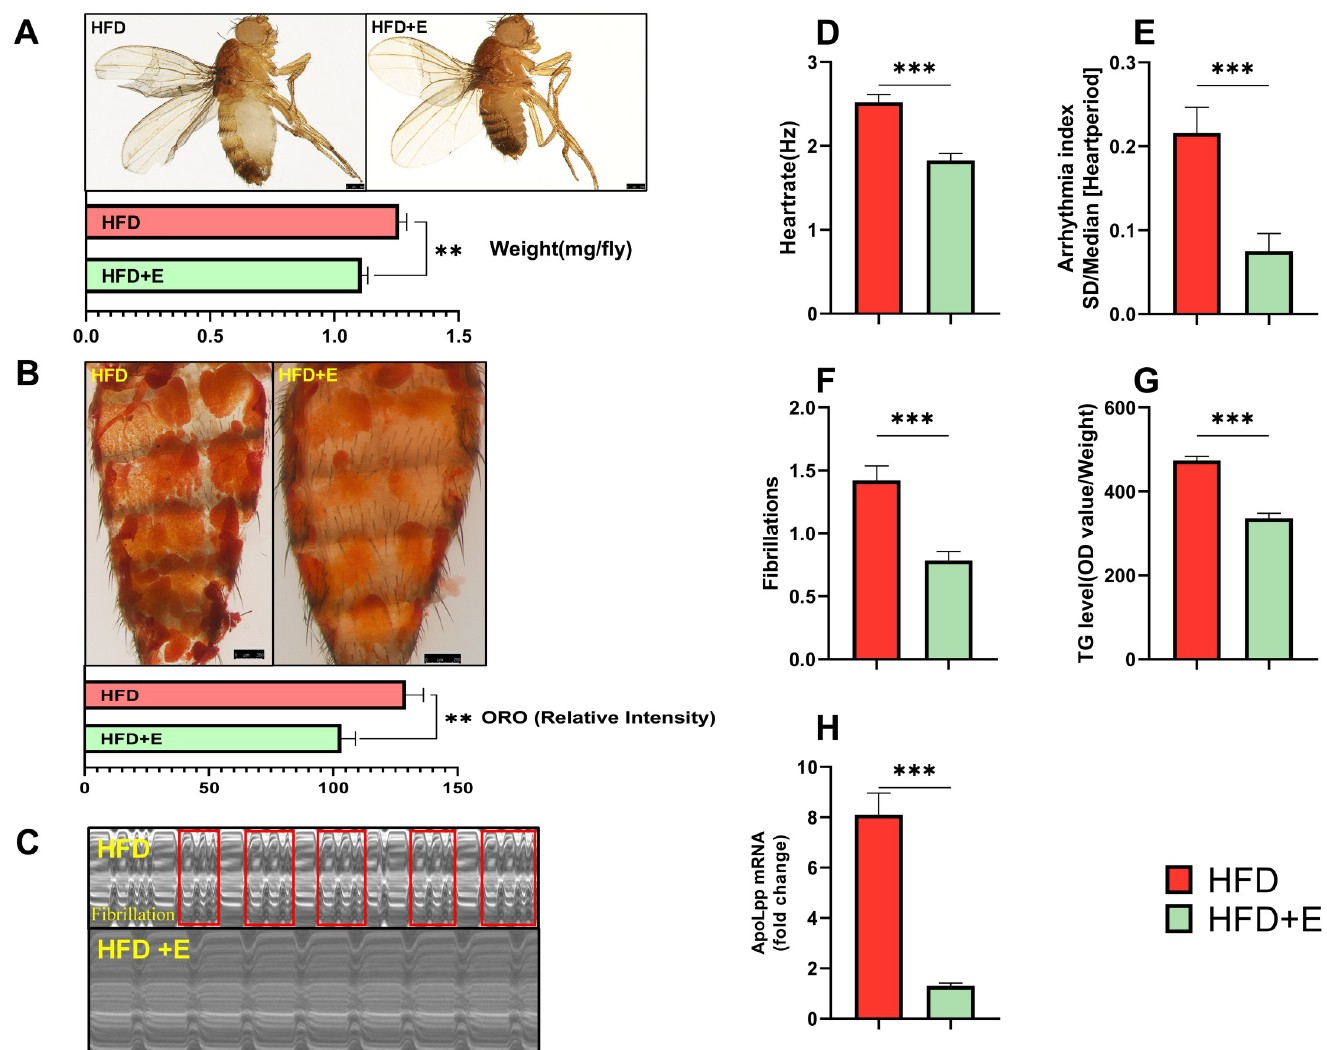
Fig 3. Regular exercise can reduce the expression level of apoLpp mRNA in cardiomyocytes and reverse the abnormal heart rhythm caused by the HFD diet. (A) Photographs and body weights of 10-day-old flies. The body weight was obtained using an electronic microbalance, N = 15. The body weight of flies in the HE group was lower than the weight of the HFD group. (B) ORO staining of the abdomen of flies. Quantification of ORO intensity, N = 5. The intensity of ORO staining in the abdomen of flies in the HFD+E group was reduced compared to the HFD group. (C) Drosophila M-mode cardiogram, the red rectangle represents fibrillation, and the interception length is 10 s (This refers to the length of the electrocardiogram of 0–10 s). (D-F) M-Mode analysis. Quantification of the fly heart rate, arrhythmia index and fibrillation, N = 30 and 20. The heart rate, arrhythmia index, and fibrillation of flies in the HFD+E group were lower than those in the HFD group. (G) Whole-body TG levels in flies. The whole-body TG level of the HFD+E group was significantly lower than that of the HFD group. N = 5, repeated three times. (H) Relative expression level of apoLpp in cardiomyocytes of flies. The apoLpp in cardiomyocytes of flies in the HFD+E group was significantly lower than that in the HFD group. The samples included at least 60 isolated